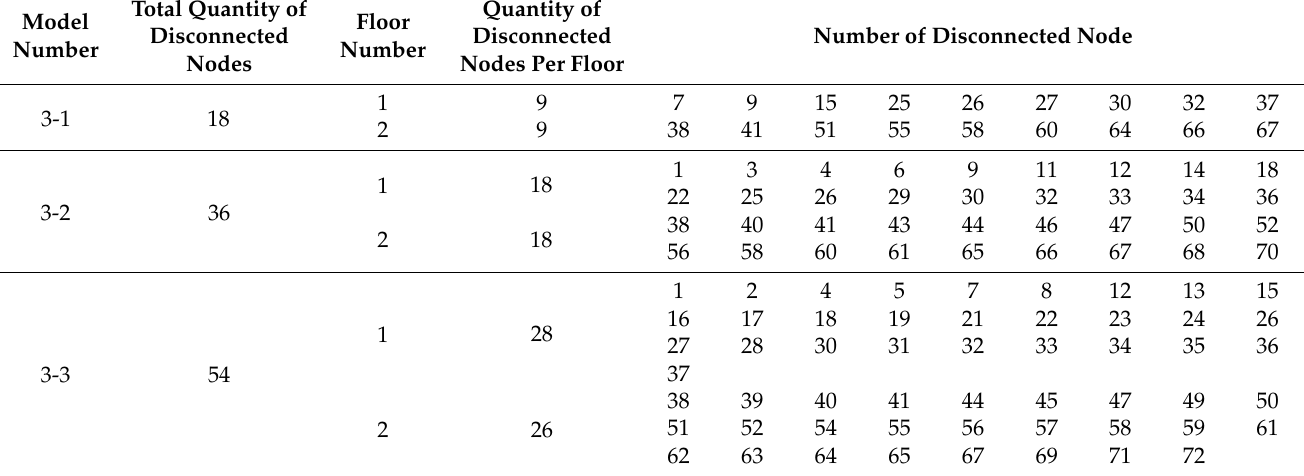
Table 3. Sampling results of stratified sampling